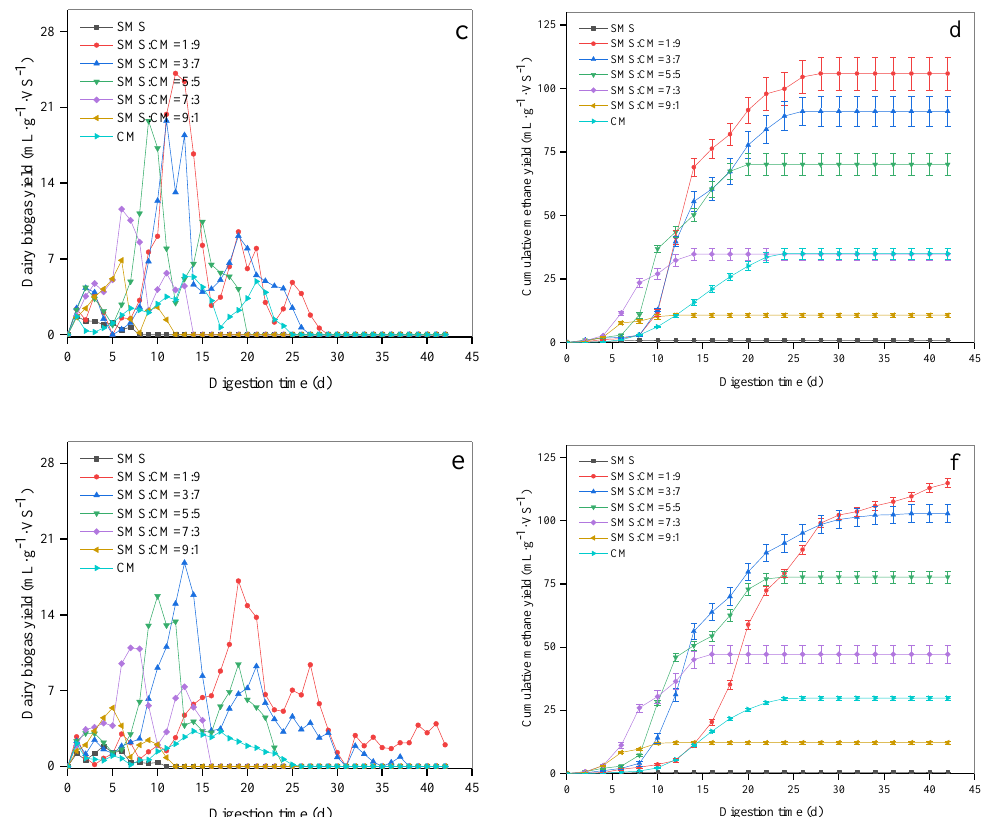
Figure 3. Variation of the cumulative methane production under different SMS ratios and total solids content ( a , c , e ) is daily biogas yield(DBY) (TS 5%, 10% and 15%); ( b , d , f ) is cumulative methane yield (CMY).